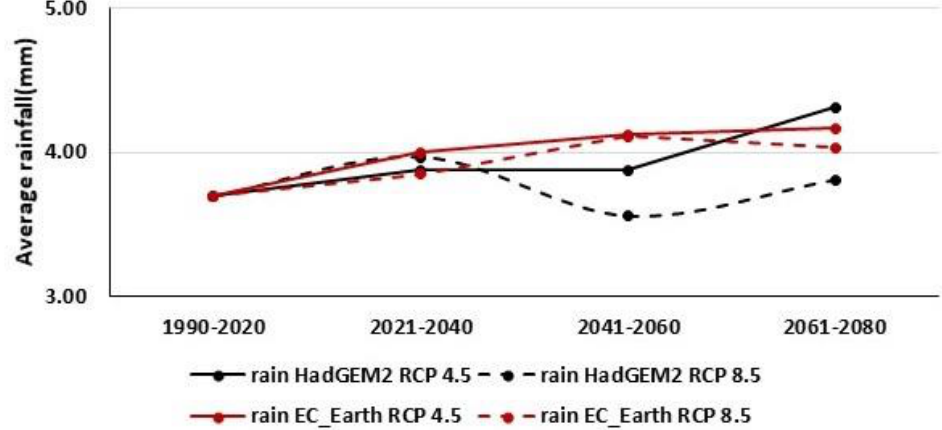
Figure 4. Change in average daily rainfall for 2021–2040, 2041–2060 and 2061–2080 for climate scenarios, RCP 4.5, and RCP 8.5 of GCM models, HadGEM2, and EC-Earth is presented in Figure 2. Table 2. Summary of change in minimum and maximum temperature and average precipitation during 2021–2040, 2041–2060 and 2061–2080 for climate scenarios: RCP 4.5 and RCP 8.5 of GCM models: HadGEM2 and